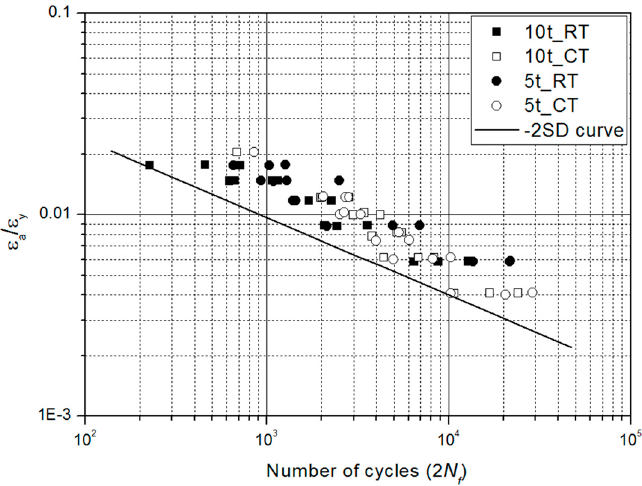
Figure 15. Normalized strain–life curve using the cyclic yield strain.